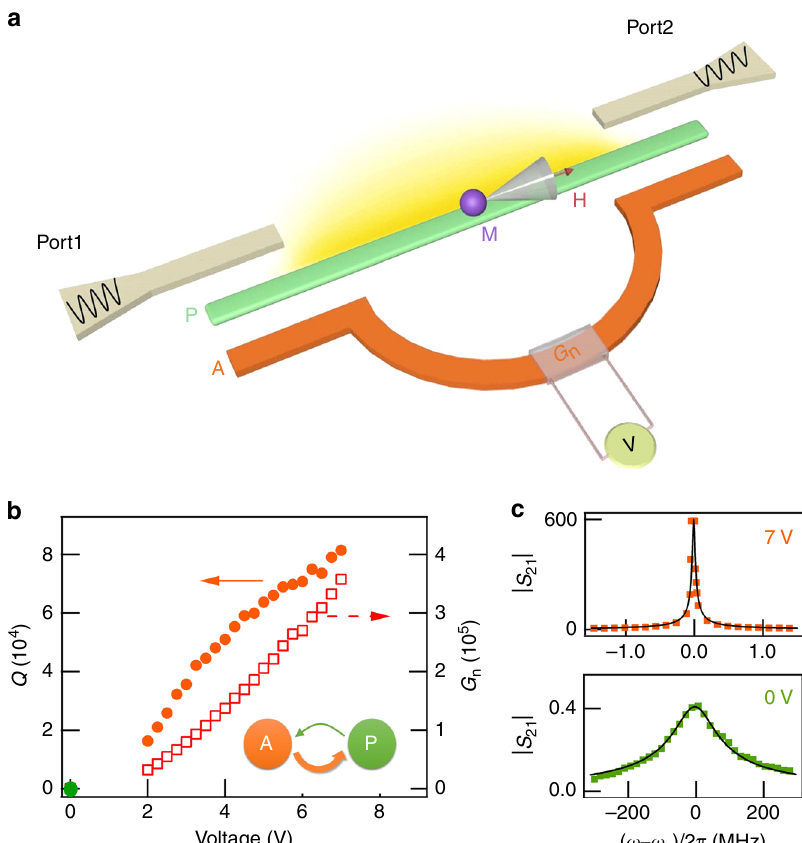
Fig. 1 Device architecture. a The A-P-M device consists of a passive cavity (P), an active cavity A with a voltage tuneable gain ( G n ), and an YIG sphere with magnons (M). b The Q -factor and G n of the A-P cavity circuit are tunable up to 81,500 and 360,000, respectively, by changing V . c , | S 21 | spectra of the cavity mode measured at V = 0 and 7 V, together with a fi tted theoretical